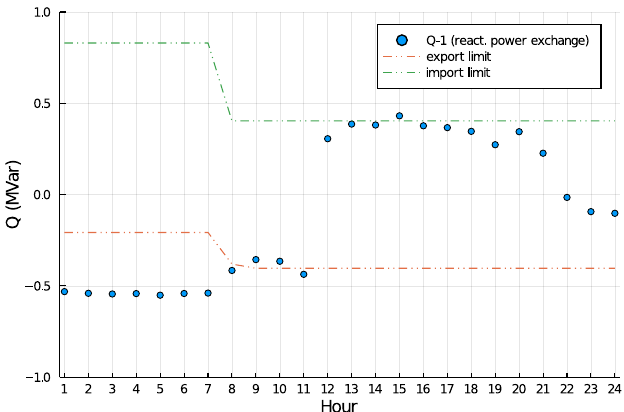
Figure 12. Reactive power exchange with the transmission system for the entire day when a QV droop curve support scheme is used (benchmark case).